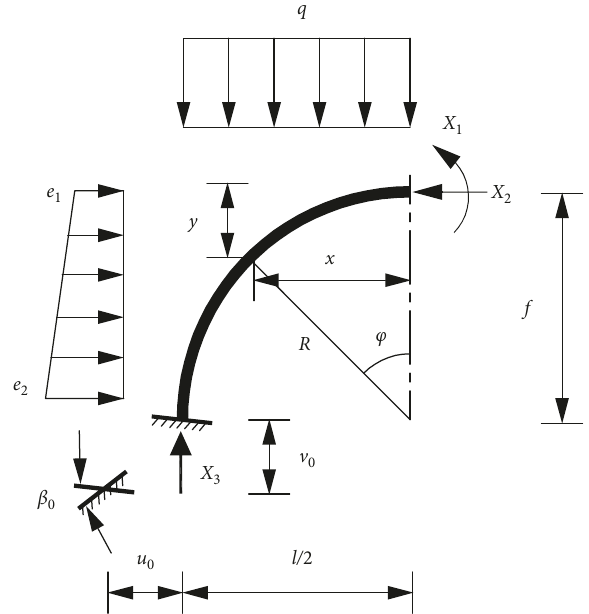
Figure 5: Mechanical analysis of the steel rib by the force method.